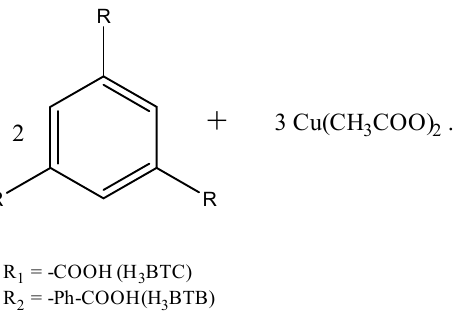
Figure 5. Mechanochemical synthesis of HKUST-1 (copper benzene-1,3,5-tricarboxylate) and MOF-14 {[Cu 3 (BTB) 2 (H 2 O) 3 ] (DMF) 9 (H2O) 2 }.